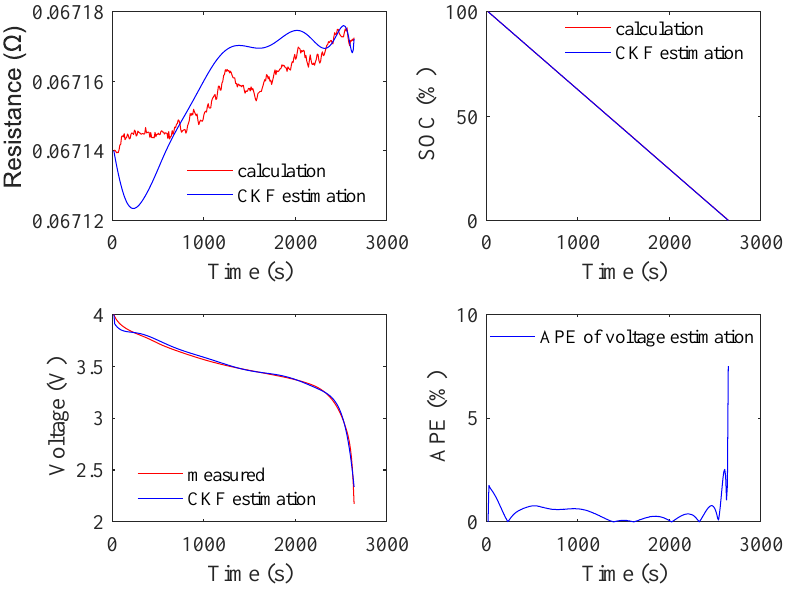
Figure 2. Degradation estimation of battery: resistance estimation; SOC estimation; voltage estimation; APE of voltage